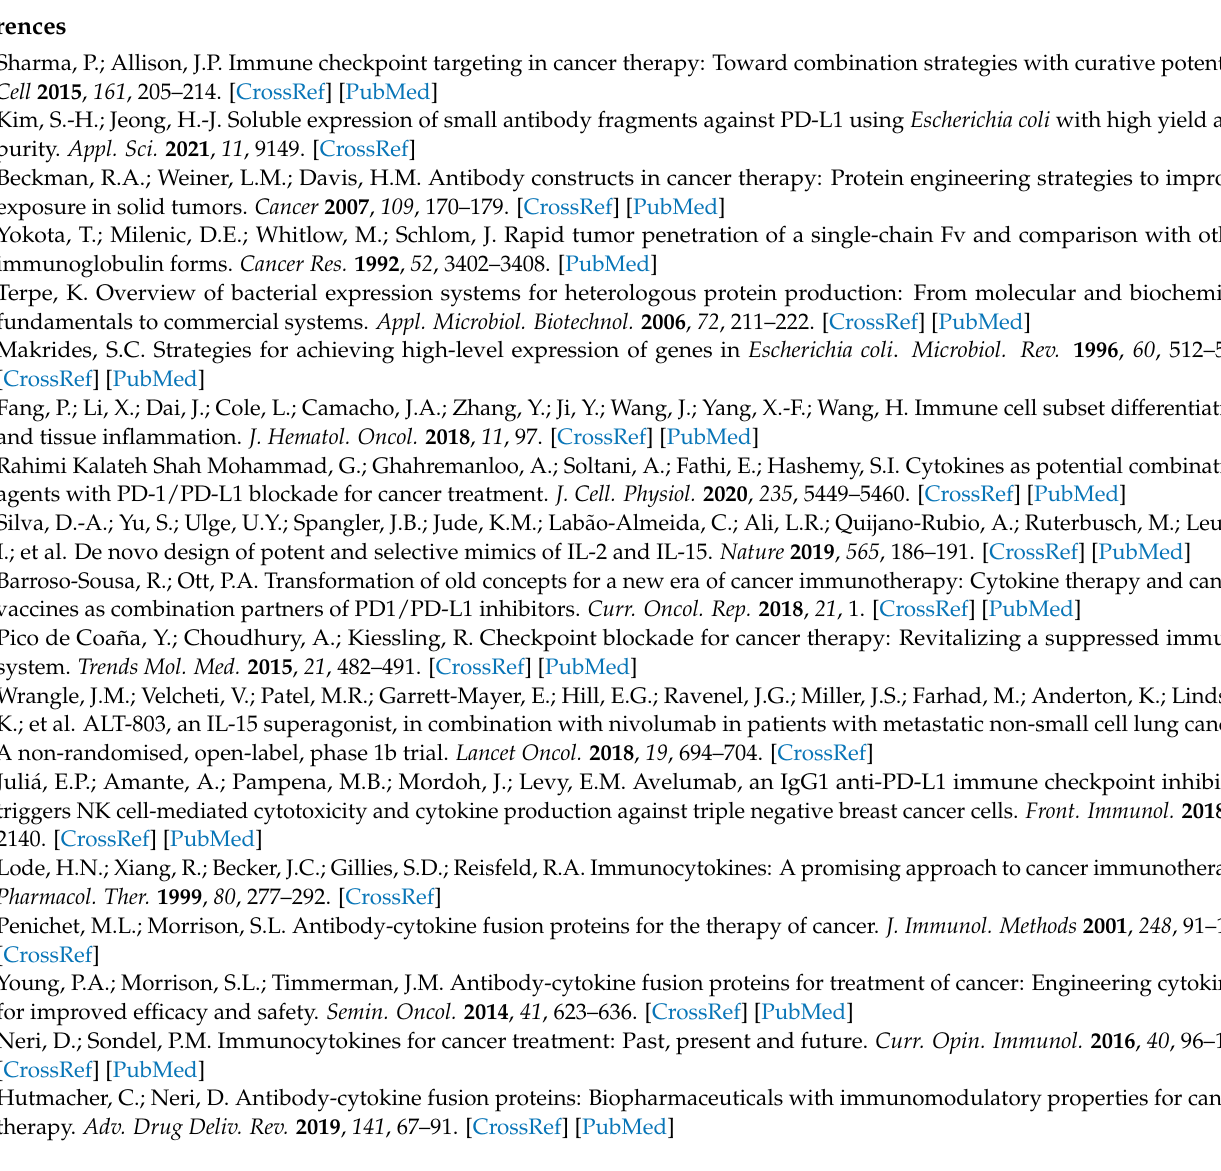
Figure S2: Measurement of the purity of proteins using ImageJ software. Each volume of the bands of protein was estimated using the ImageJ software (A,B) and the purity was calculated by (area of target band)/(total area of whole bands appeared on the gel) × 100